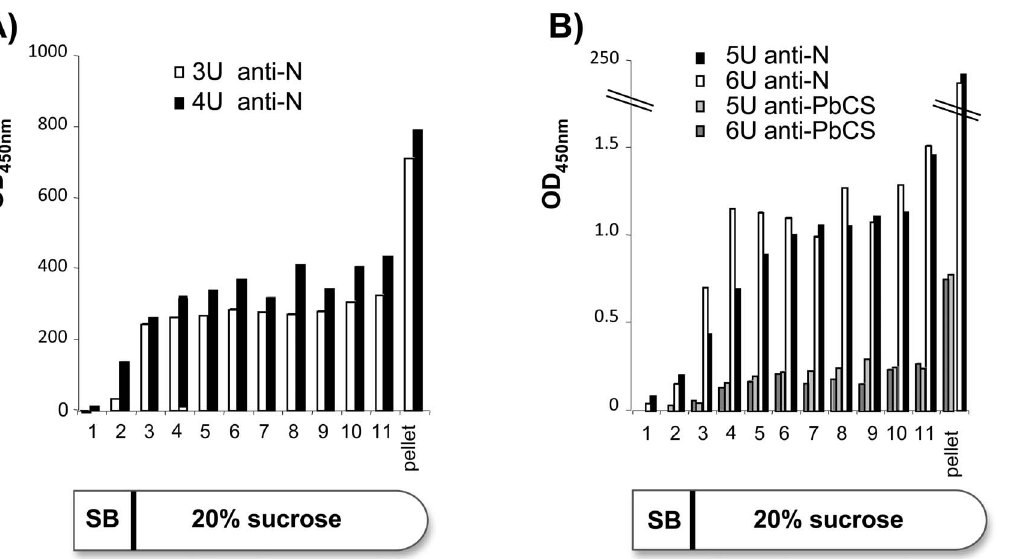
Figure 3. ELISA quantification of N or PbCS proteins in ultracentrifugation (U) fractions and pellets of SMD1168 lysates expressing N alone at 871 ng/YU (A) or N-PbCS at 12 ng/YU (B). Yeast cultures, lysates and ultracentrifugations were performed in duplicate (3 U and 4 U for N expressing yeast, and 5 U and 6 U for N-PbCS yeast). Values correspond to optical densities at OD 450 nm (taking OD 620 nm as reference) multiplied by sample dilutions. SB: suspension buffer.